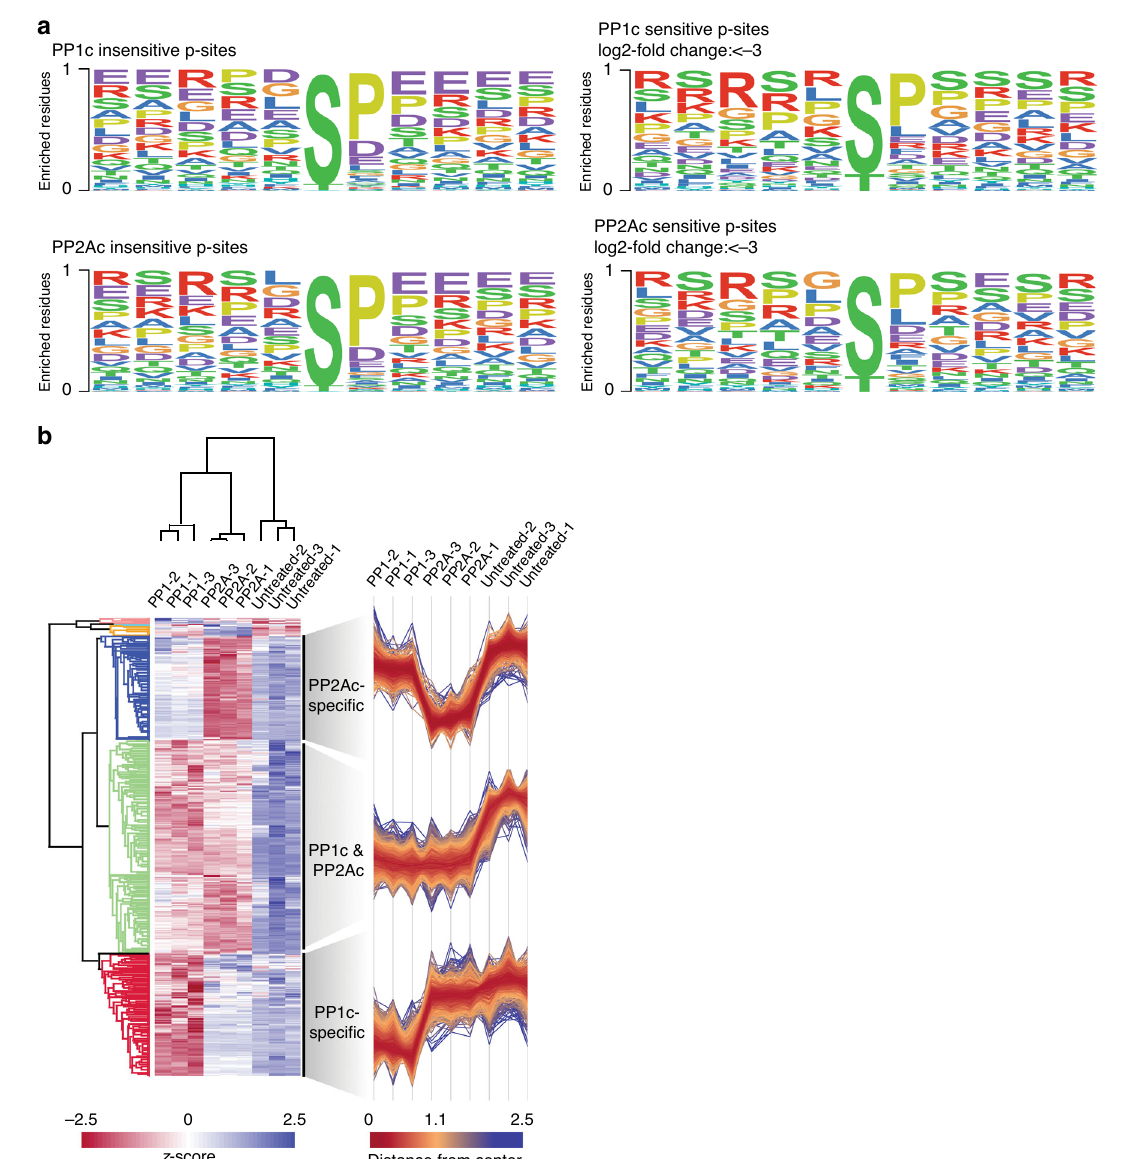
on six annotated 14-3-3-binding sites for PP1c, whereas only two sites in SRSFs and three 14-3-3-binding sites, but not containing a RXXpS motif, were identi fi ed as selective substrates for PP2Ac (Table 1). These fi ndings corroborate the intrinsic af fi nity of PP1c for the RXXpS motif. PP1c dephosphorylates GAB2 . We next moved our attention to the RXXpS motif at residue pS210 of the docking protein GRB2- associated-binding protein 2 (GAB2), which was depho- sphorylated by PP1c but not PP2Ac in the phosphoproteomic assay (Table 1, Supplementary Data 2). GAB2 was previously identi fi ed as 14-3-3-binding protein 43 , but a link between this